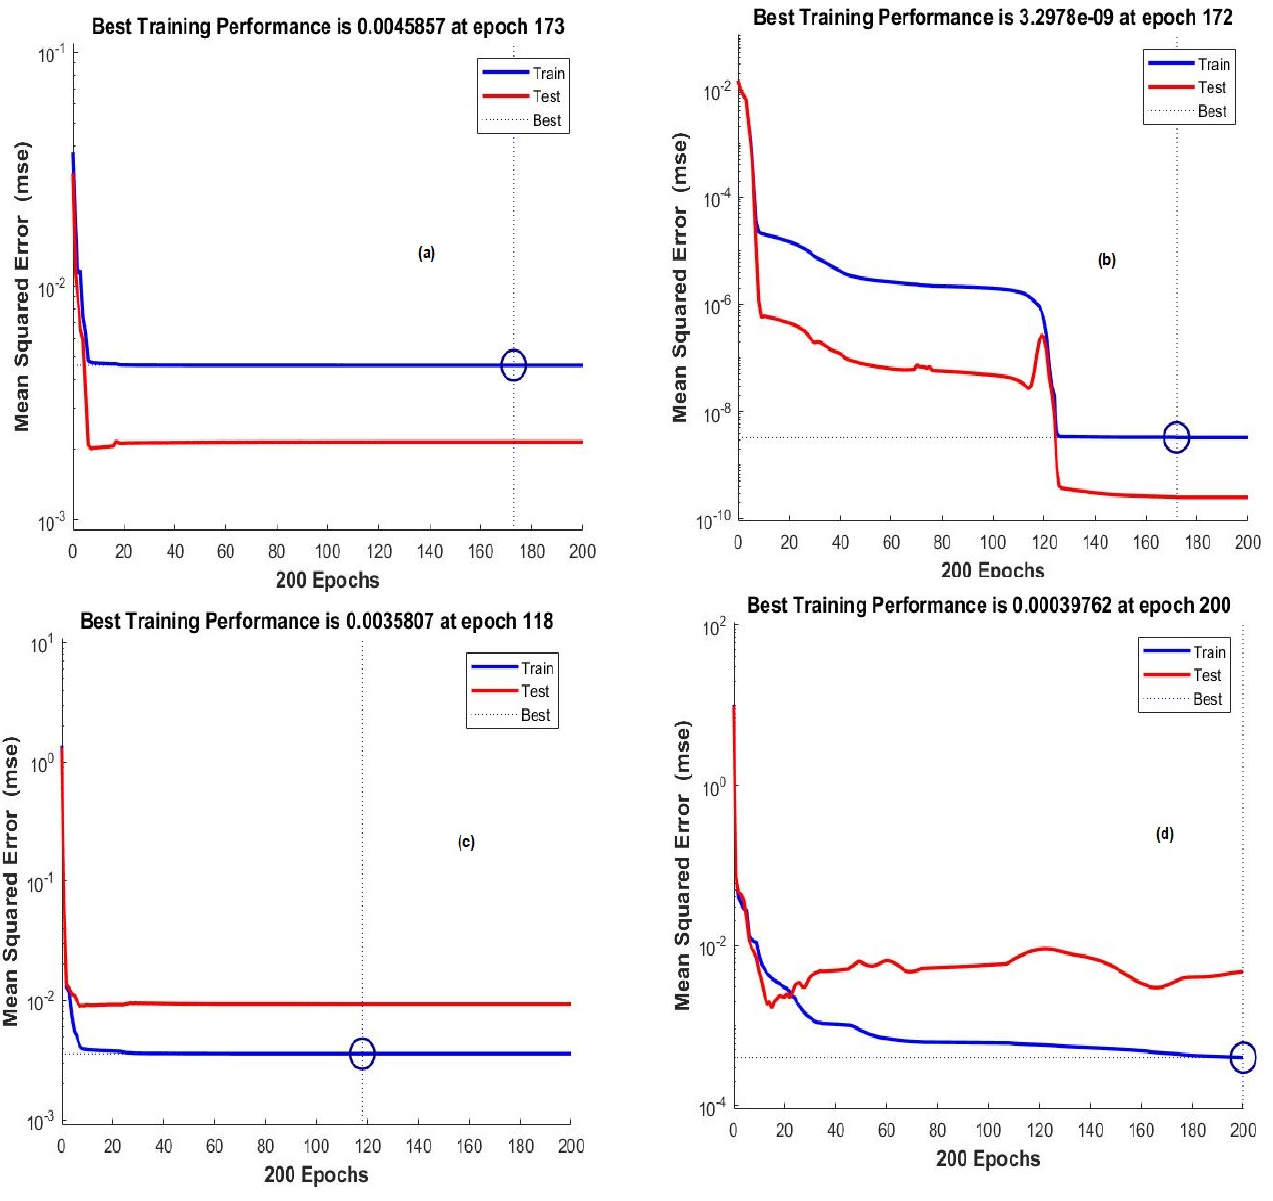
Figure 5. Performance of ANN for predicting housing prices: ( a ) Riyadh, ( b ) Dammam, ( c ) Jeddah, and ( d ) Al-Khobar.